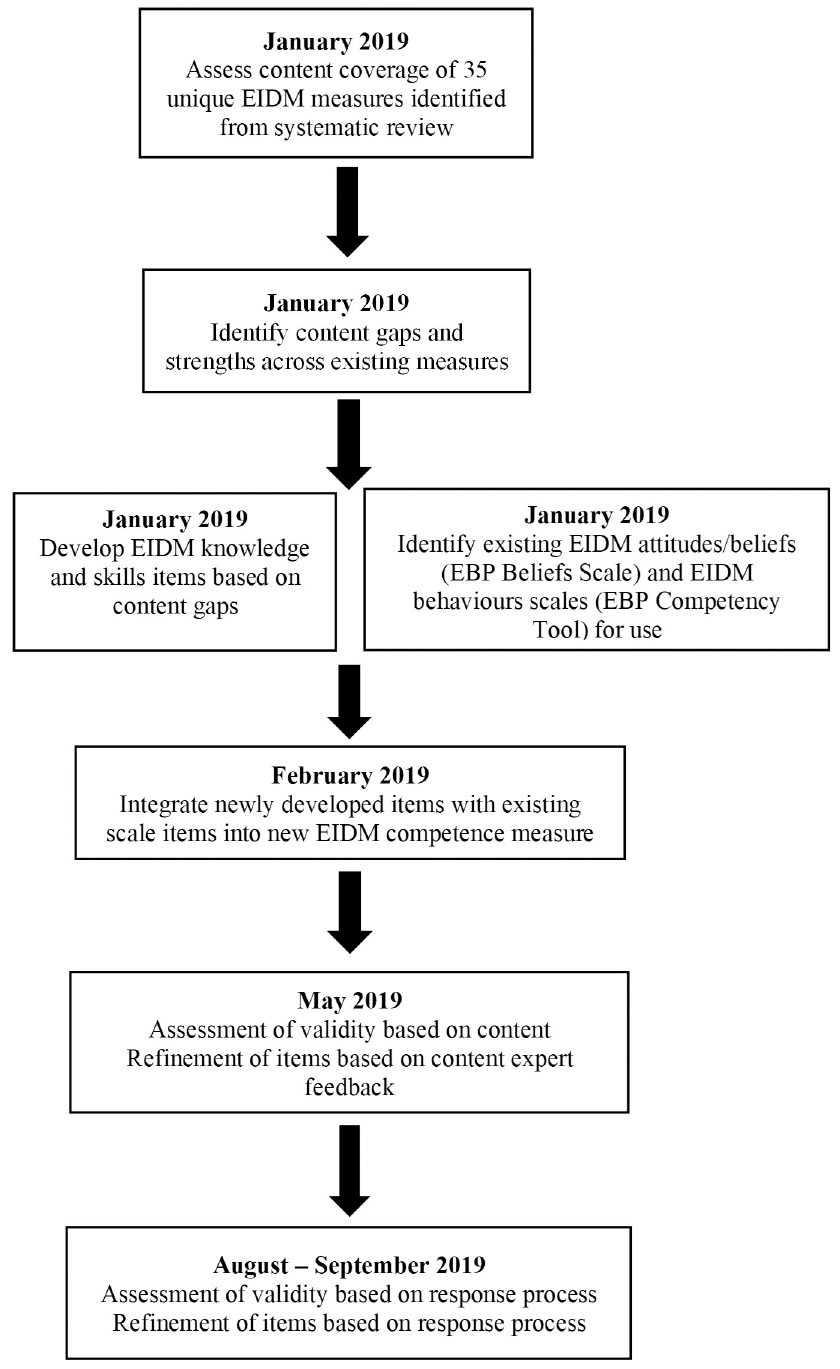
Fig 1. Development process of EIDM competence